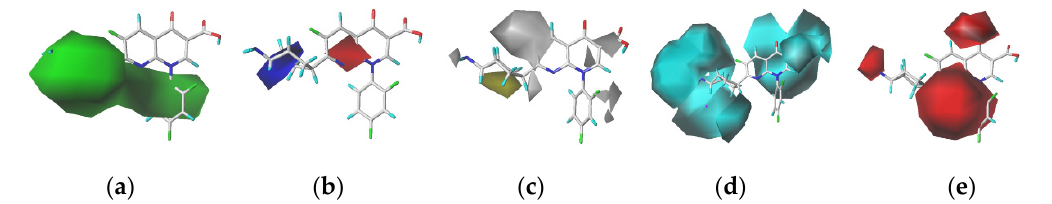
Figure 2. Contour maps of CoMSIA model, steric fields ( a ); electrostatic fields ( b ); hydrophobic fields ( c ); hydrogen-bond donor field ( d ); and hydrogen bond receptor field ( e ).